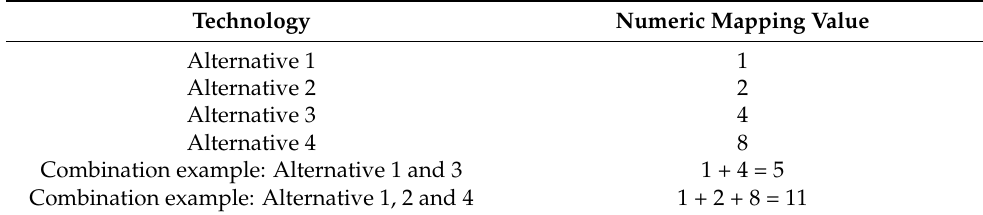
Table 8. Binary mapping of technology